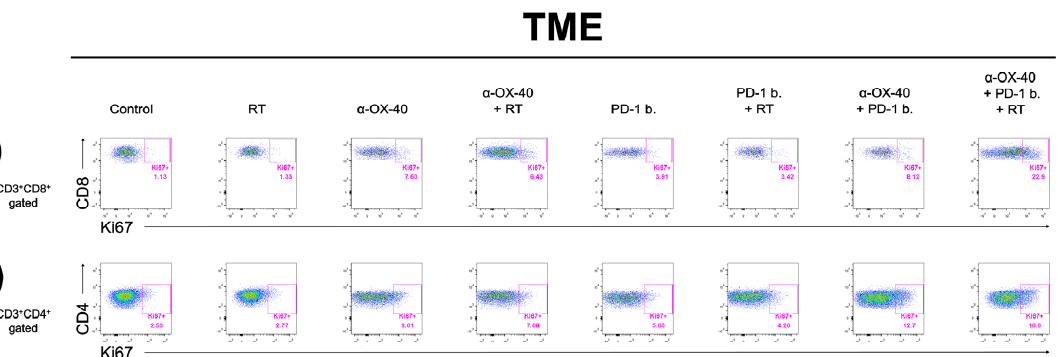
Figure 5. Proliferative T cell compartments in the tumor microenvironment. Representative flow cytometry plots of ( a ) CD8 + Ki67+ and ( b ) CD4 + Ki67+ T cells. The percentage of T cells expressing the proliferative marker Ki-67 in ( c ) CD8+ and ( d ) CD4+ T cell populations in the tumor microenvi- ronment was calculated by flow cytometry. * p < 0.05, ** p < 0.01, *** p < 0.001, **** p < 0.0001. Abbre- viations: CON, control; RT, radiotherapy; ns, not significant. 4. Discussion ICIs targeting PD-1, PD-L1, and CTLA-4 have rapidly become a major cancer treat- ment option over the past decade. The recent success of ICIs has also highlighted the im- mune susceptibilities of early-stage and metastatic TNBCs [9–11]. However, most patients with metastatic TNBC demonstrate a suboptimal survival and a poor response to ICI mon- otherapy, even in patients with PD-L1+ tumors [12,13]. Therefore, combination strategies that complement the insufficient anti-tumor immune response in TNBC warrant investi- gation. To overcome the limited efficacy of PD-1B monotherapy in TNBC, we evaluated the combination of α -OX40, RT, and PD-1B, which has not been tested elsewhere, in a synge- neic murine 4T1 TNBC model. Triple combination therapy significantly improved tumor control of the irradiated primary tumor as well as the non-irradiated secondary tumor in both 4T1-luc and luciferase-untagged 4T1 tumors, compared to the controls, monothera- pies, and dual therapies (Figure 1). Long-term survival was also superior in the triple combination group (Figure 1h). The high-dose hypofractionated RT schedule used in the current study, “SBRT,” is known for its high local control rate, ranging from 75–90%, and its potential survival ben- efit in various oligometastatic tumor types [37,38]. In our preclinical study, the tumor con- trol rate of SBRT was further enhanced by the addition of α -OX40 and PD-1B when com- pared to RT alone, RT + α -OX40, or RT + PD-1B (Figure 1a–d). Enhanced tumor control